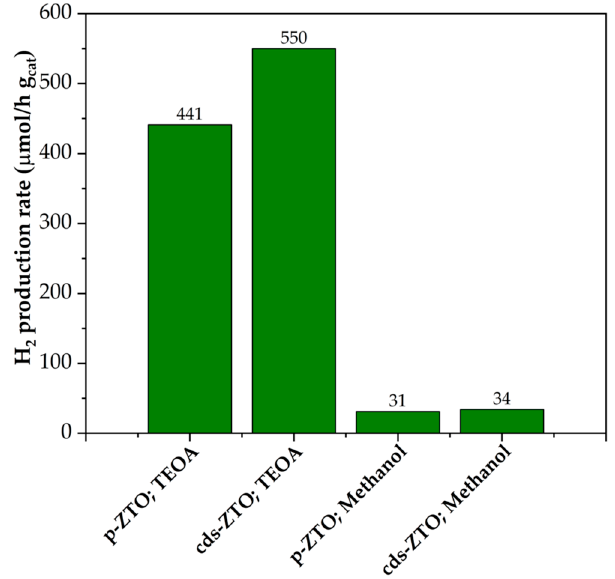
Figure 14. Hydrogen evolution rates of cds-ZTO and p-ZTO samples using triethanolamine and methanol as sacrificial agents.